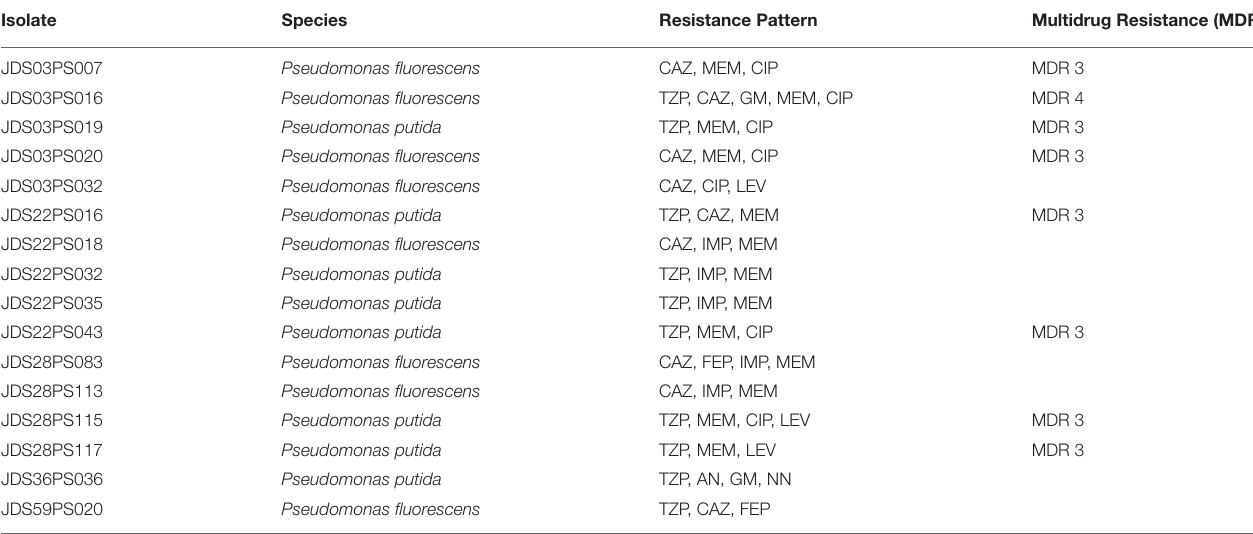
TABLE 4 | Resistance pattern of isolates showing resistances to three or more of the tested antibiotics.